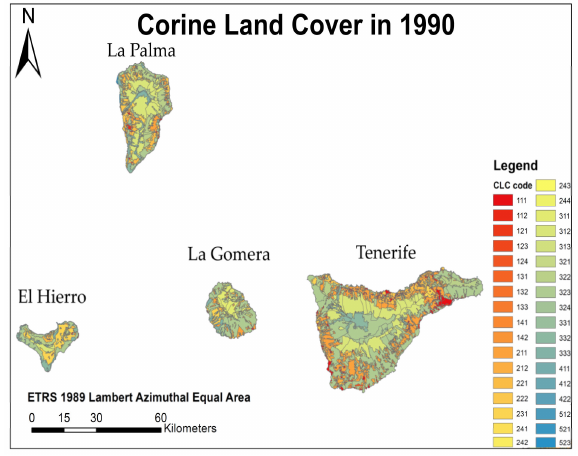
Figure A11. Thematic cartography regarding the land-use changes in the South of Canary Archipelago in the year 1990.